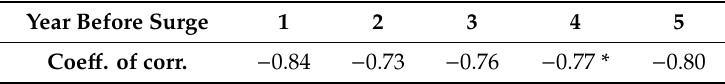
Table 3. The relationship between CfD and CfE up to 5 years before the active phase of the glacier surge expressed as a correlation coe ffi cient. Year Before Surge 1 2 3 4 Coe ff . of